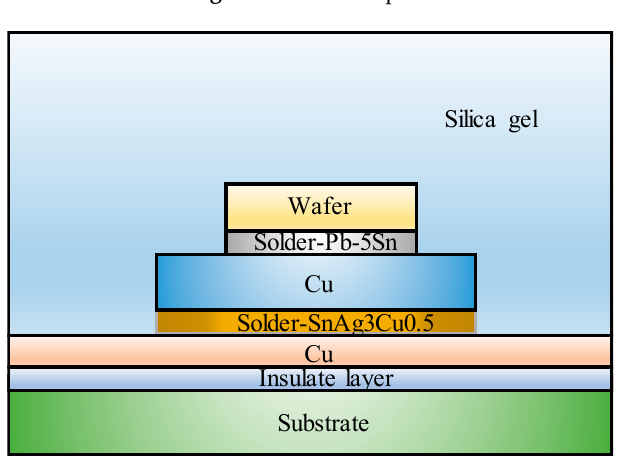
Figure 2. Structure of a single chip.